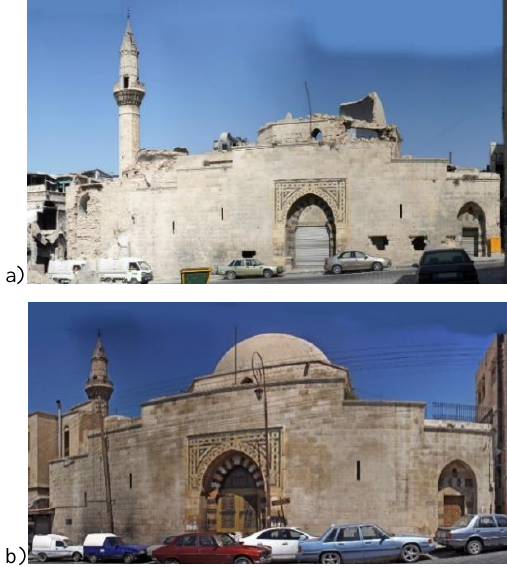
Figure 2. Matbackh al Ajami, current situation (a) and how it was in 2010 (b).